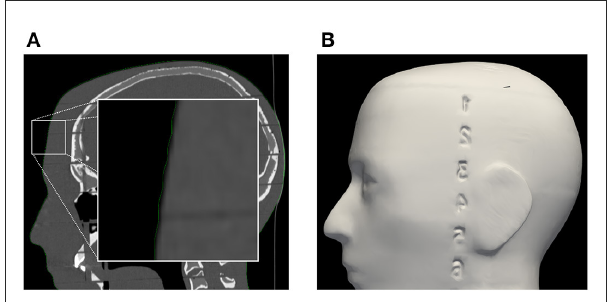
FIGURE3 (A) Segmentation of phantom CT data used for the creation of (B) the target surface-model during pre-clinical registration